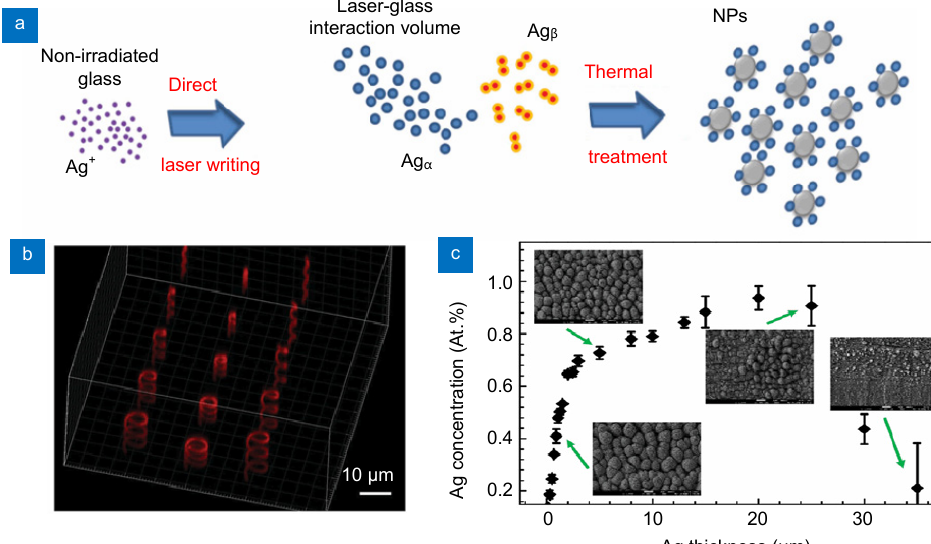
Fig. 3 | Laser induced materials components change. ( a ) Schematic of formations of Ag nanoparticles inside silver containing zinc phosphate glasses by femtosecond laser. ( b ) Laser induced helicoidally-distributed emitting silver clusters arrays. ( c ) Demonstration of femtosecond laser doping of silver into titanium surface. Figure reproduced from (a, b) ref. 61 , WILEY-VCH Verlag GmbH & Co. KGaA, Weinheim; (c) ref. 59 , WILEY-VCH Verlag GmbH & Co. KGaA, Weinheim.